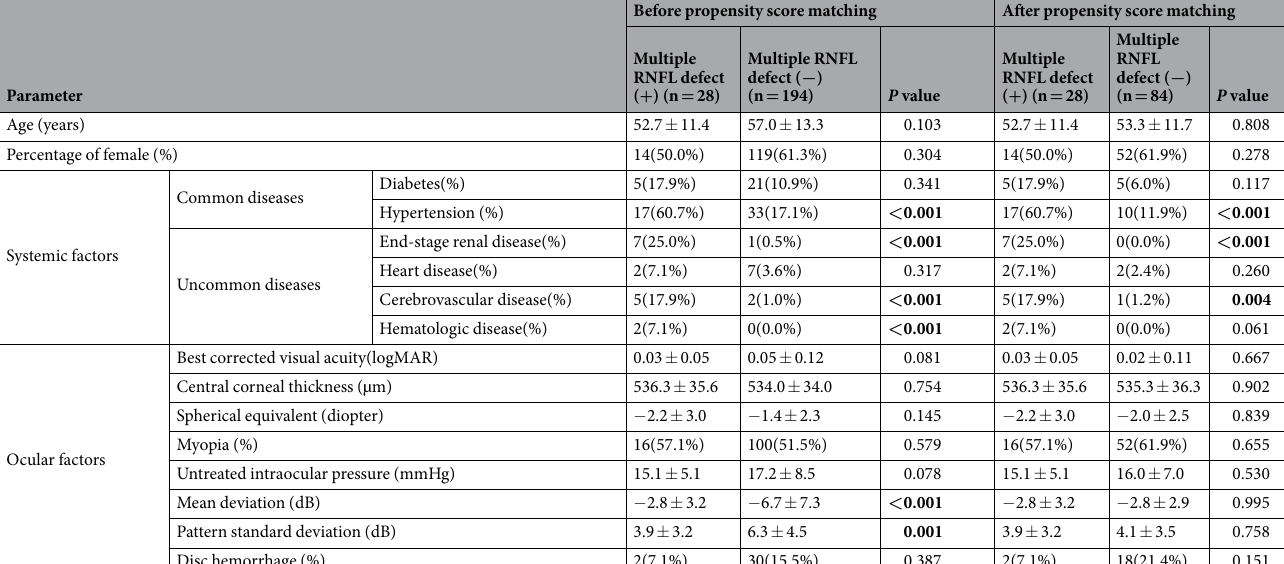
Table 1. Demographics of patients RNFL, retinal nerve fiber layer. Continuous variables are expressed as n